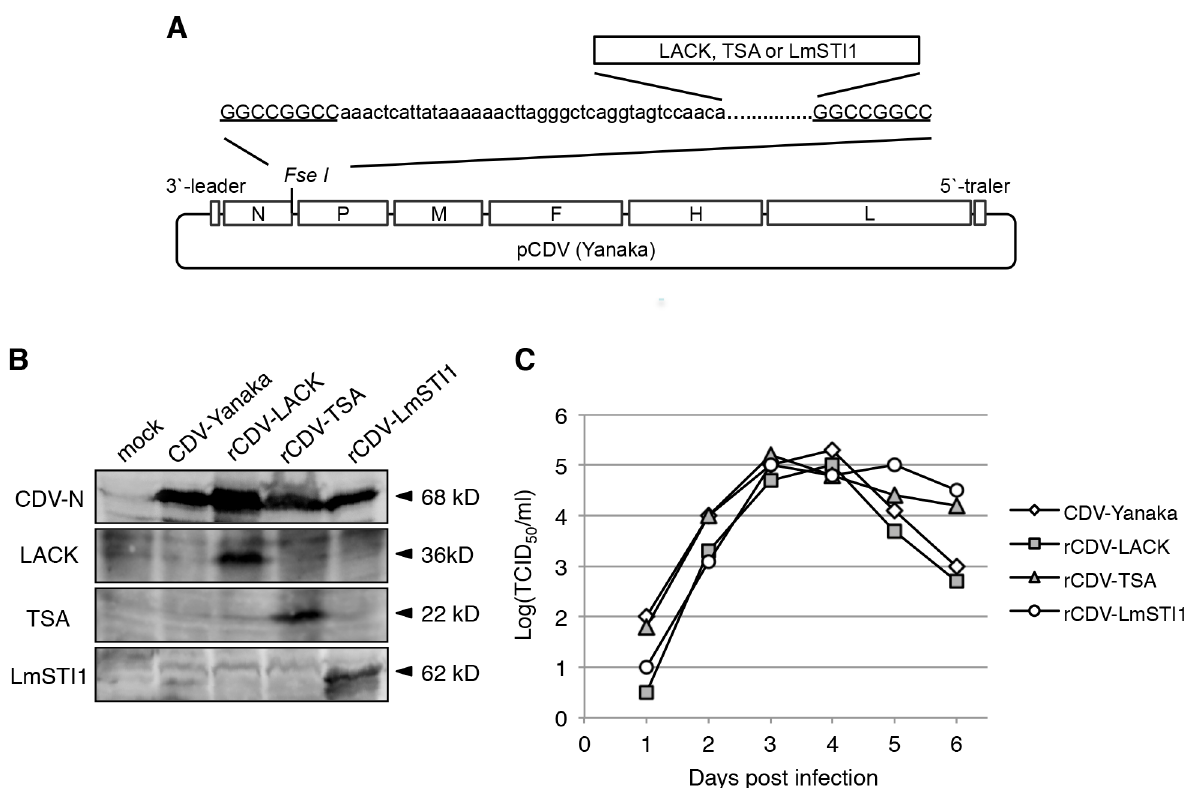
Fig 1. Generation and in vitro characterization of rCDVs. (A) Schematic model of pCDV (Yanaka) with the Fse I site introduced between the N and P genes. Each Leishmania antigen gene carrying the CDV transcription signal unit (lower case) and Fse I site (underlined) was inserted at the Fse I site. (B) The rescued recombinant viruses were identified by immunoblotting analysis. Cell lysates were examined with anti-CDV-N, anti-LACK, anti-TSA and anti-LmSTI1 antibodies. The bands corresponding to CDV-N (68 kDa), LACK (38 kDa), TSA (22 kDa) and LmSTI1 (62 kDa) are indicated by arrowheads. (C) Kinetics of recombinant viral growth. B95a cells were inoculated with a recombinant virus at a multiplicity of infection of 0.01, and then harvested on the indicated day. The titers of the viruses were determined using a TCID 50